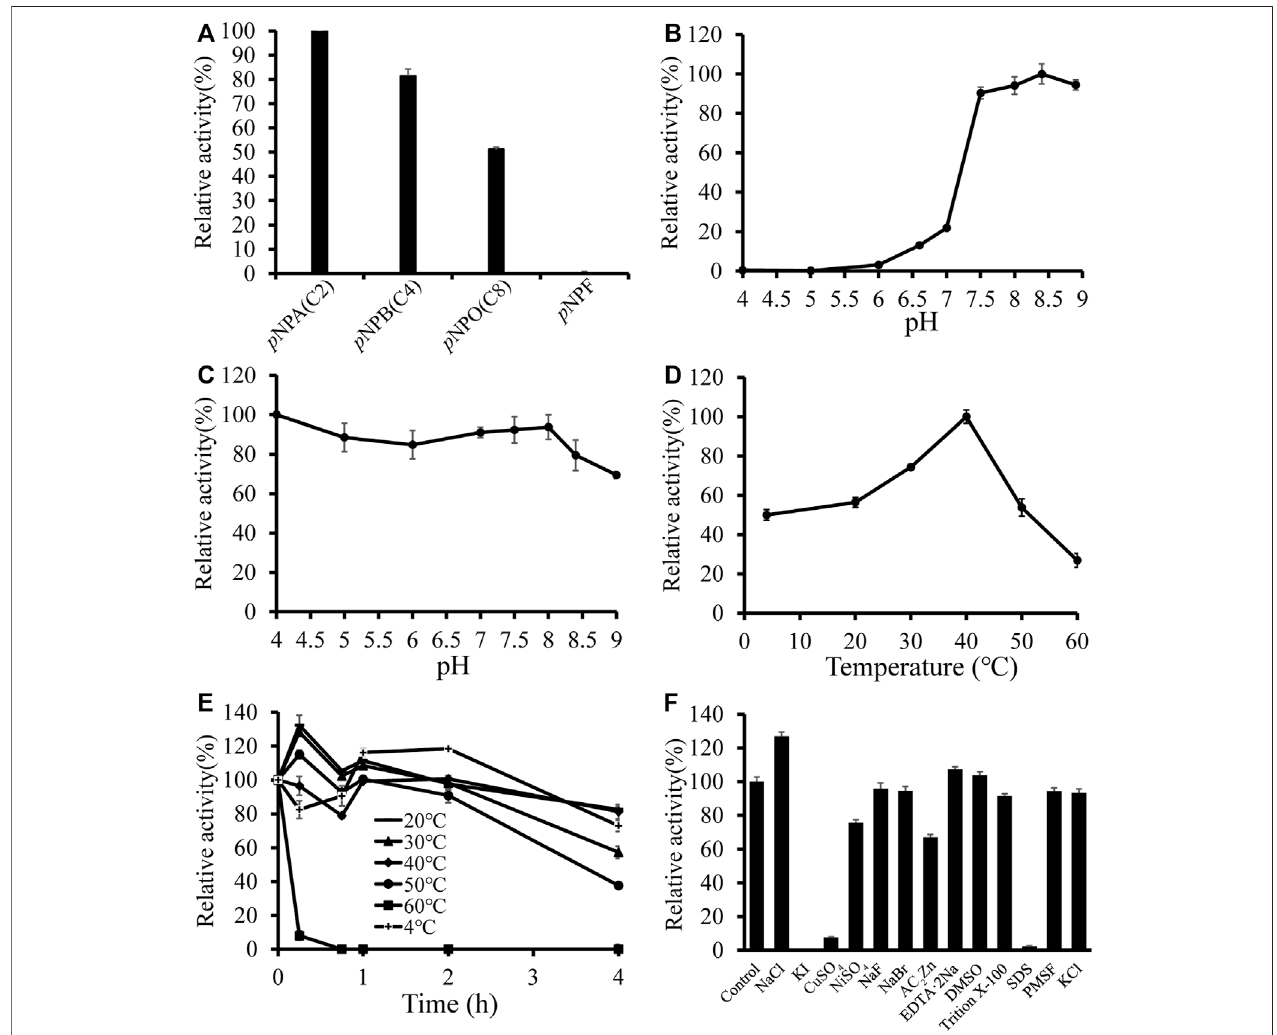
FIGURE 3 | Biochemical characterization of Df FAE. (A) Substrate preference of Df FAE was measured with p -nitrophenyl esters. The observed maximum activity wasde fi nedas100% (B – C) EffectofpHon Df FAEactivity (B) andstability (C) . (D – E) Effectoftemperatureon Df FAEactivity (D) andstability (E) .4 ° C,plussign(+);20 ° C, minussign (-);30 ° C,solidtriangle( ▲ );40 ° C, solidtilted square ( ◆ );50 ° C,solidcircle ( C );60 ° C,solidbox ( ■ ).Theactivity measured withoutpreincubationisde fi ned as 100% (F) Effect of various metal ions and detergents on Df FAE activity. The activity of the blank control group was taken as 100%. The error bars indicated the standard deviations obtained from three independent